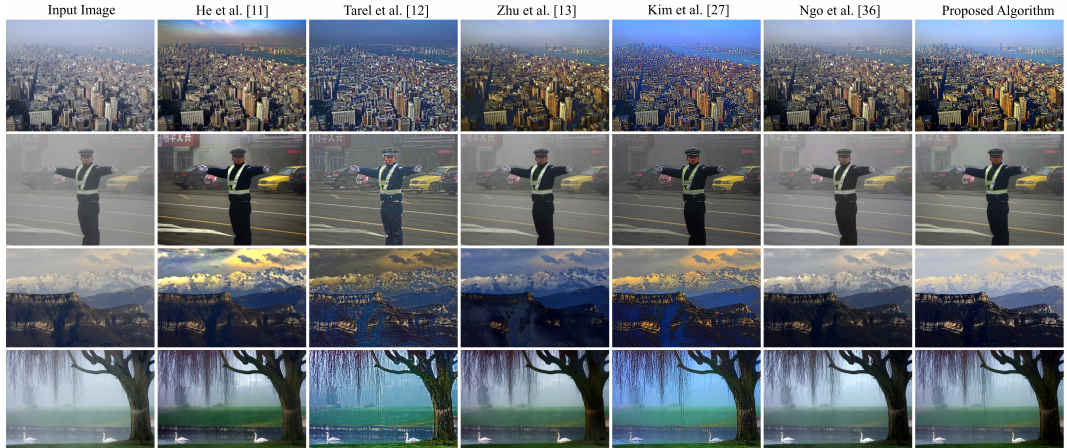
Figure 13. Qualitative assessment of the outputs produced by different algorithms on other real-world